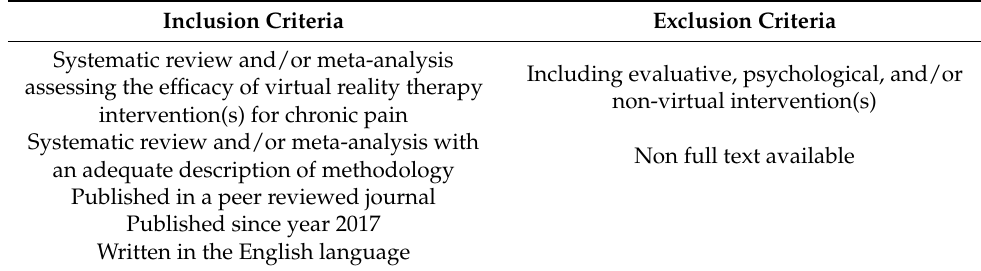
Table 2. Eligibility criteria of literature search. Inclusion Criteria Exclusion Criteria Systematic review and/or meta-analysis Including evaluative, psychological, and/or assessing the efficacy of virtual reality therapy non-virtual intervention(s) intervention(s) for chronic pain Systematic review and/or meta-analysis with Non full text an adequate description of methodology